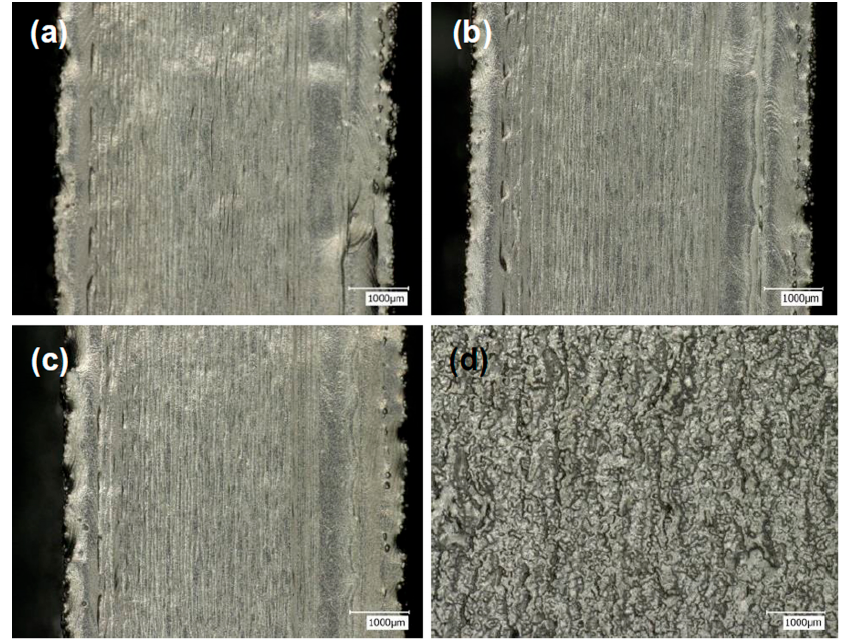
Figure 3. Optical microscopy images showing the surface morphology of ( a ) N1; ( b ) N2; ( c ) N5 from the top view; and the surface conditions of ( d ) N6 from the side